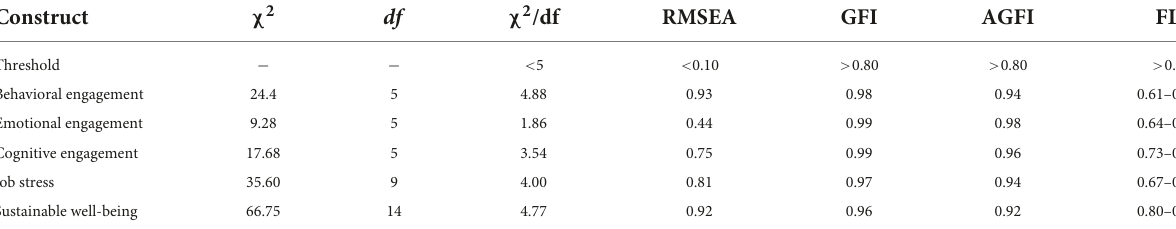
TABLE 2 First-order confirmatory factor analysis (CFA).